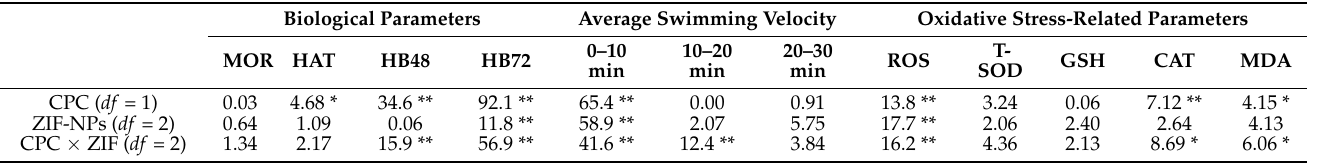
Table 1. Summary of generalized linear model testing the statistical significance for the effect of cetylpyridinium chloride (CPC), ZIF-8 nanoparticles (ZIF-NPs), and their interaction (CPC × ZIF) on early life stages of zebrafish ( Danio rerio ) 1.